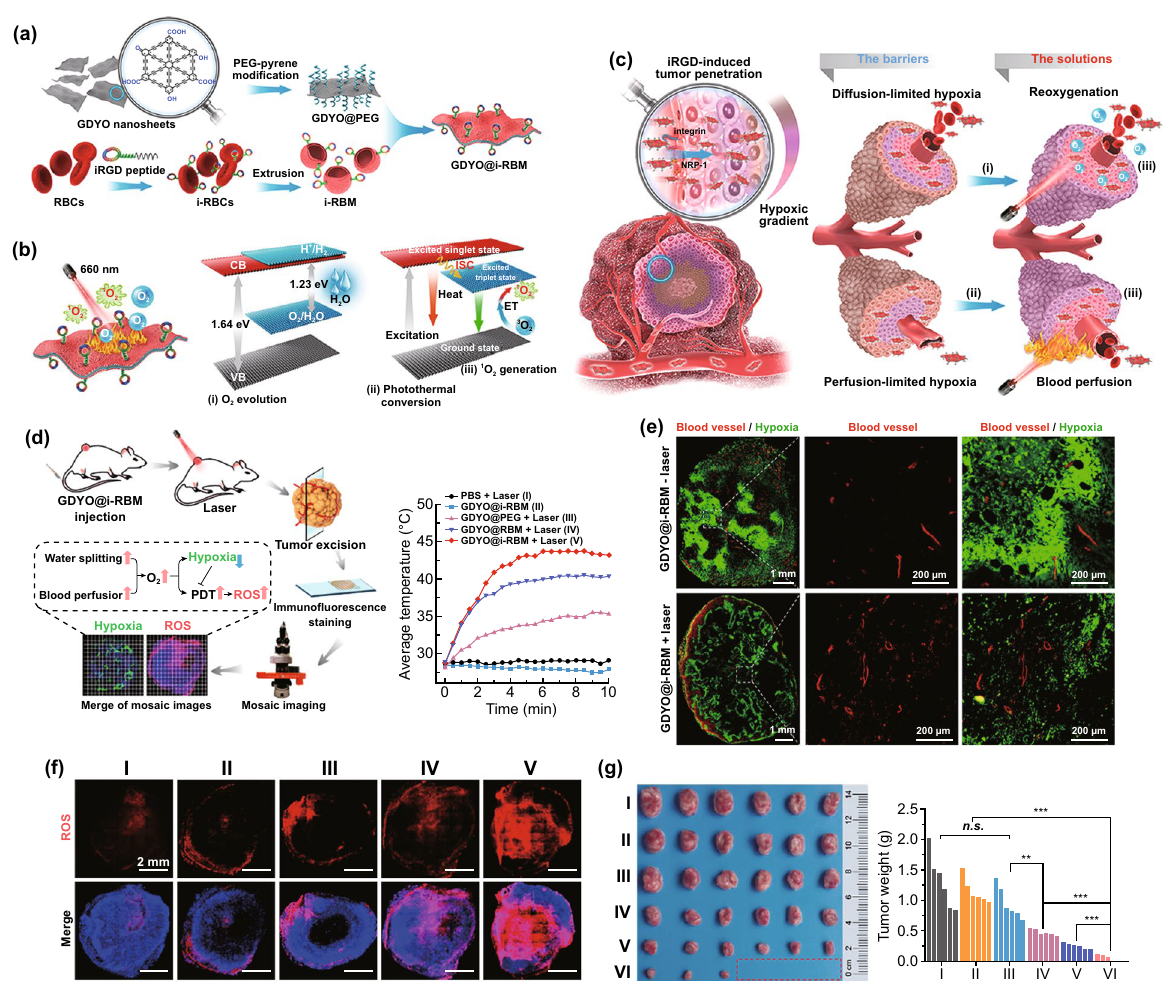
Fig. 10 a Schematic illustration of the synthetic process of GDYO@iRBM. GDYO@i-RBM was obtained by coating PEG functionalized GDYO nanosheet with i-RBM, which were extracted from iRGD anchor-modified RBCs followed by extrusion through a porous membrane. b Schematic illustration of the working principles of GDYO@i-RBM. c i-RBM on the surface of GDYO facilitates the accumulation and deep penetration in the tumor. Meanwhile, under 660 nm laser irradiation, O 2 evolution and hyperthermia caused by GDYO can overcome O 2 -diffusion-limited and perfusion-limited hypoxia barriers and lead to efficient PDT ablation of tumors. d Schematic illustration showing the evaluation of hypoxia and 1 O 2 levels in tumor, and temperature increase of the tumors upon irradiation. e Hypoxia immunofluorescence and vessel morphometric analyses of tumor slices. The blood vessels and hypoxia regions were stained with anti-CD31 antibody (red) and hypoxia probe (green), respectively. f Representative ROS fluorescence images of tumor slices. g Photos and weight of the tumor tissues obtained on day 22 post-treatment. Reproduced with permission from Ref.